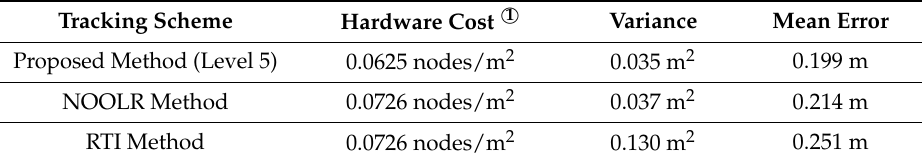
Table 2. Passive tracking performance comparison.